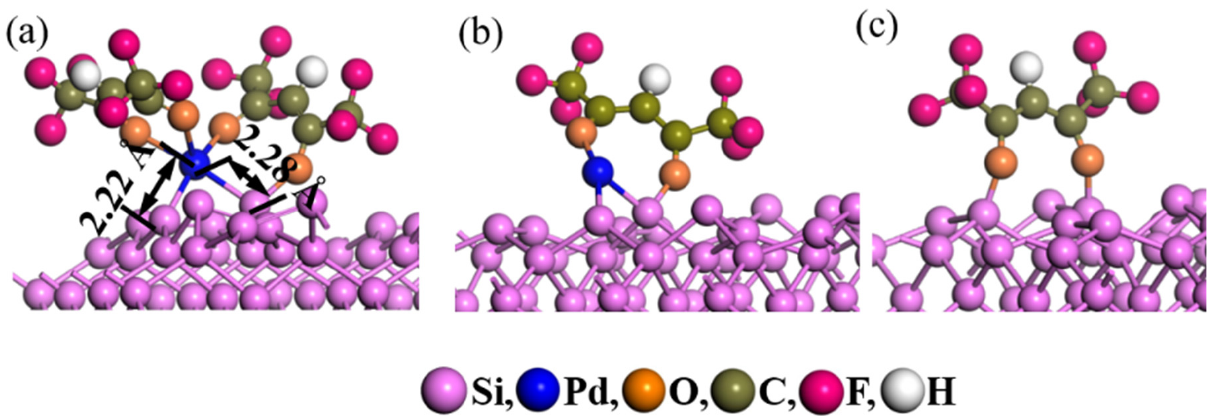
Figure 2. The obtained clean Si (100) with ( a ) Pd(hfac) 2 *, ( b ) Pd(hfac)* or ( c ) hfac* after geometry optimization. The reaction energy for Reaction (1) was − 1.87 eV. DFT calculations performed showed that Pd(hfac) 2 * dissociated to Pd(hfac)* and hfac*. The optimized structures are shown in Figure 2b,c. The lowest adsorption energy of Pd(hfac) on the clean Si (100) surface was − 4.08 eV. After Pd(hfac) was adsorped at the B2 site, two Pd–Si bonds were formed. The coordination configuration of Pd was preserved with a coordination number of 3. Figure 2c shows the most stable structure of hfac adsorption on the Si. Hfac preferentially adsorbed with the perpendicular species axis at the B1 site with an adsorption energy of − 4.21